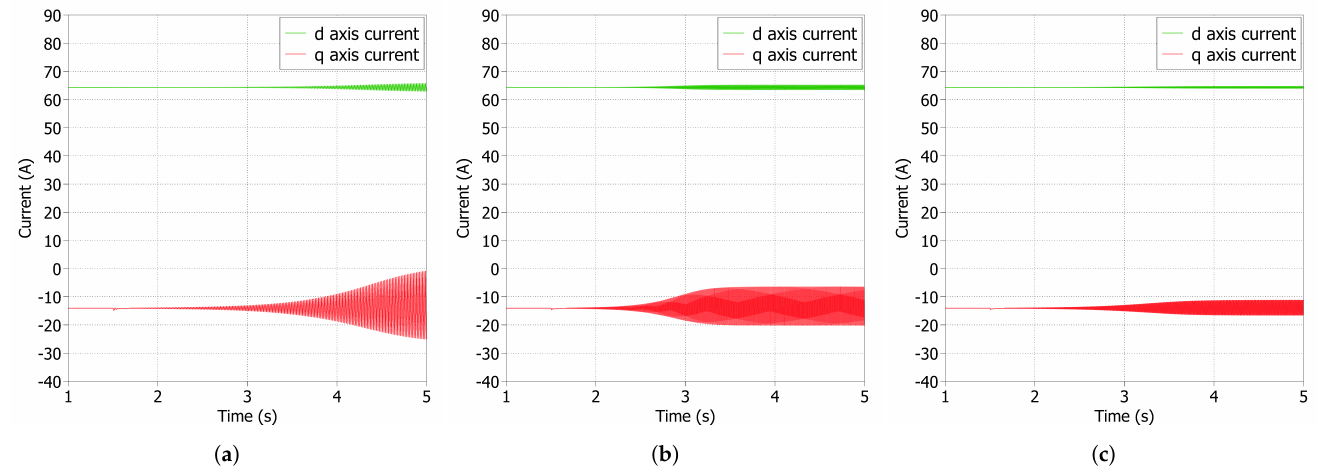
Figure 17. Time domain simulations of the VSC inductor current I L for different AVC filter cases. The stability impact of AVC in the weak grid (SCR = 1.5) is observed, caused after the ramp change in K I , a 0 to its critical value K I , acr at t = 1.5 s; ( a ) K I , acr = 285 when f AVC,LPF = 20 Hz; ( b ) K I , acr = 270 when f AVC,LPF = 50 Hz; ( c ) K I , acr = 260 when f AVC,LPF = 100 Hz.